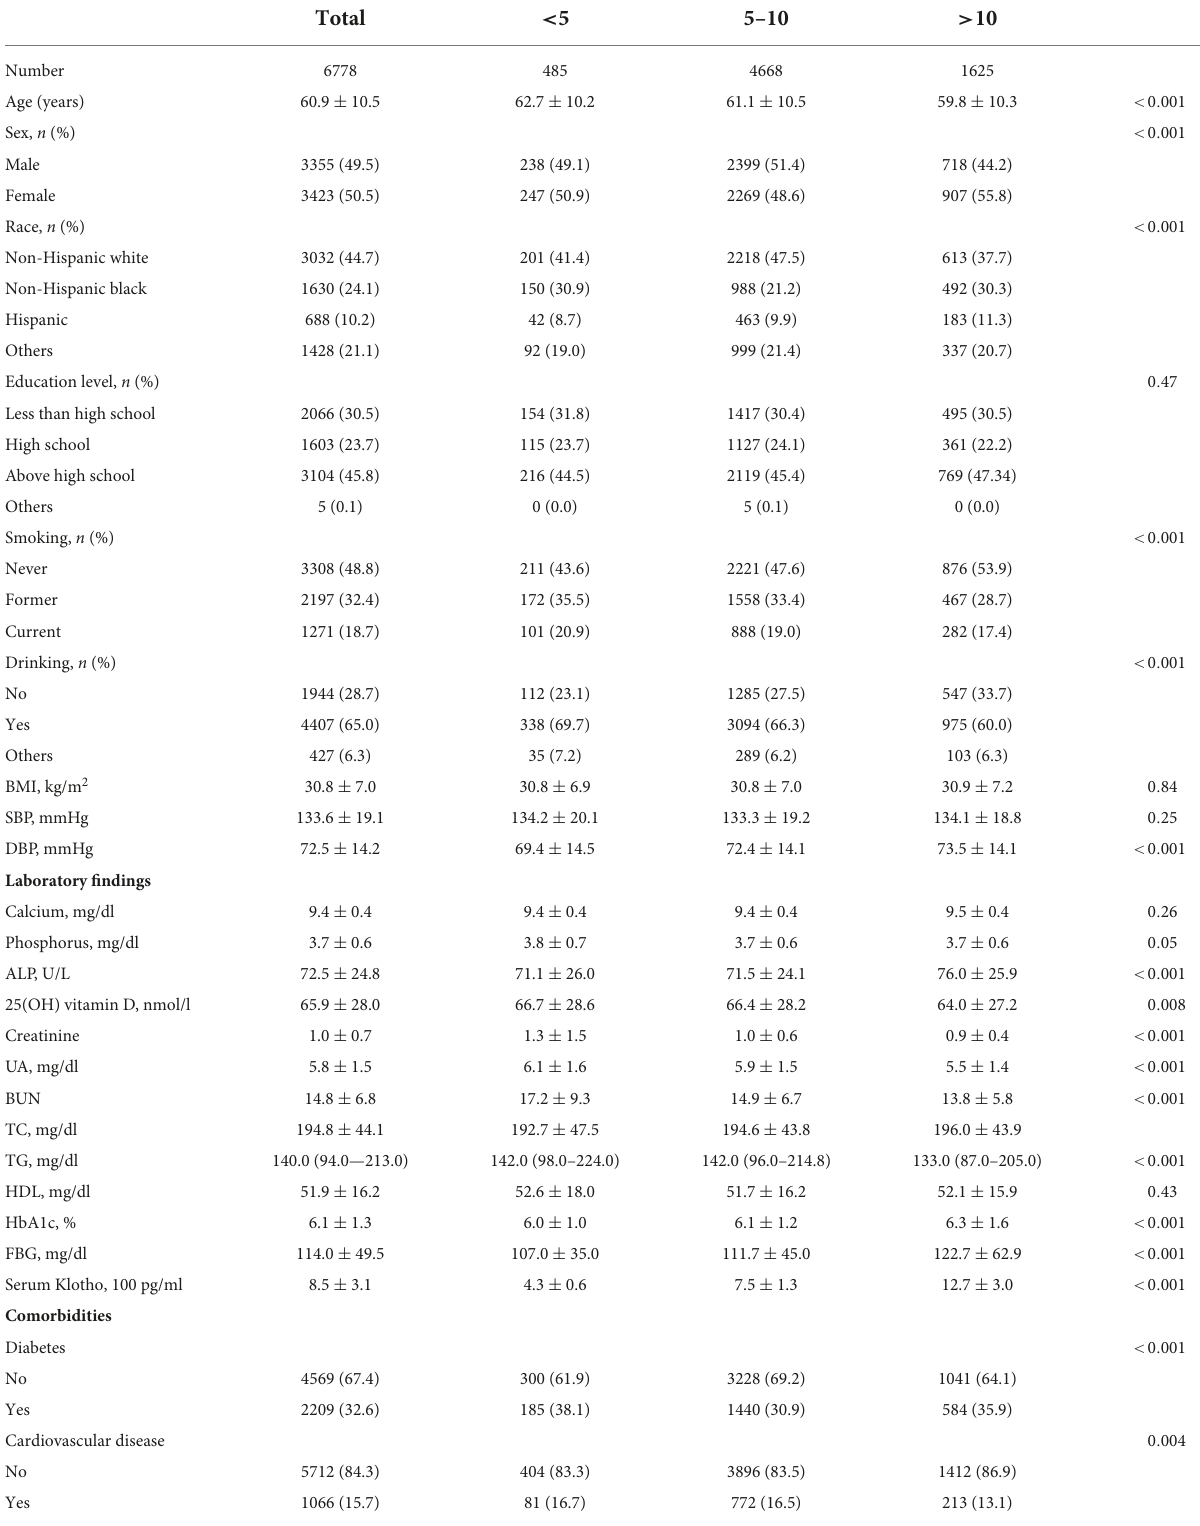
TABLE 1 Characteristics of American hypertensive populations according to serum Klotho concentrations. Serum Klotho (100